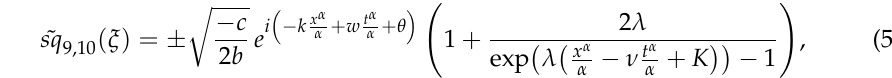
in (56); α is a beta random 5